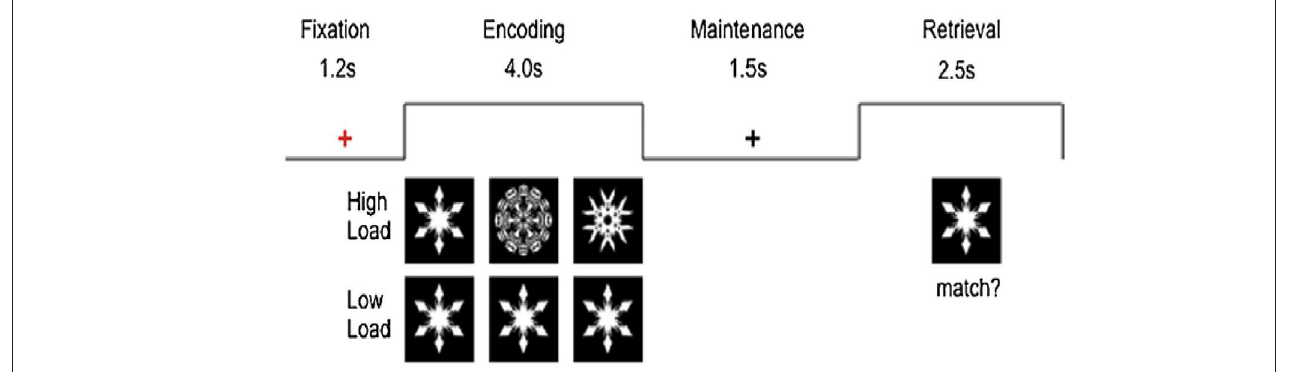
FIGURE 1 | Sternberg visual memory task presented by E-prime in the MRI